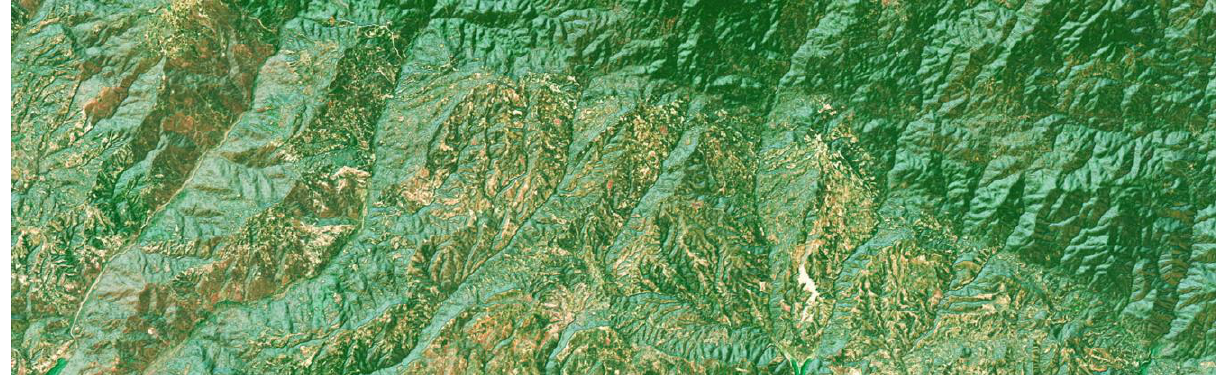
Figure 6. Connection of COMPO_P image with SRTM-1. Full resolution reduced twice to show greater area (scale 1:400 000